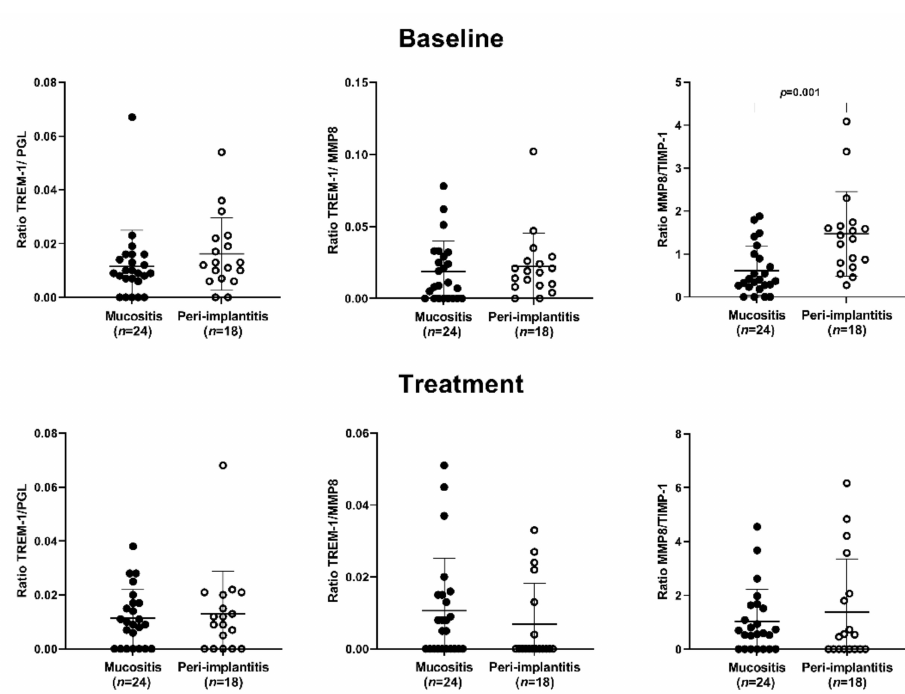
Figure 3. Ratio comparisons of total sTREM-1/PGLYRP-1, sTREM-1/MMP-8, and MMP-8/TIMP-1 in peri-implant mucositis patients and peri-implantitis patients at baseline and after peri-implant treatment. p ≤ 0.05 (Mann–Whitney U test).